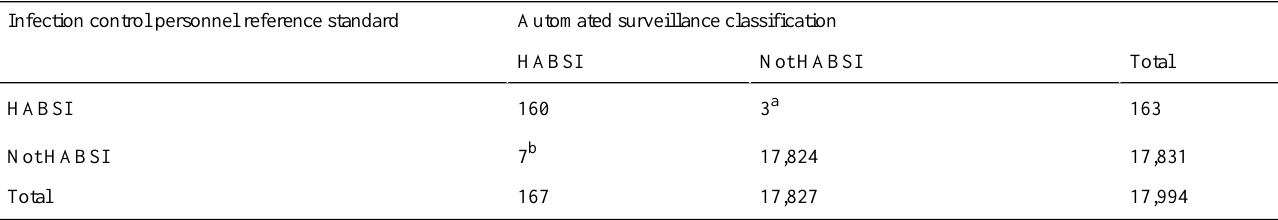
Table 1. Comparison of the case detection results of the health care-associated bloodstream infection surveillance and classification system with infection control personnel reference standard between the periods October 1 and October 31, 2012.